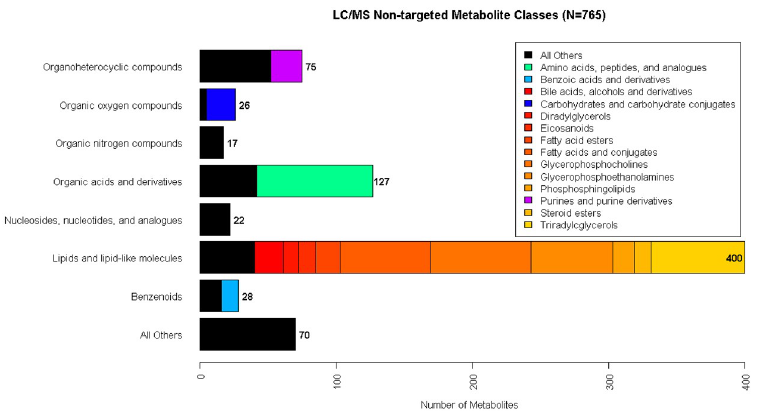
Fig 1. LC-MS non-targeted metabolite classes.